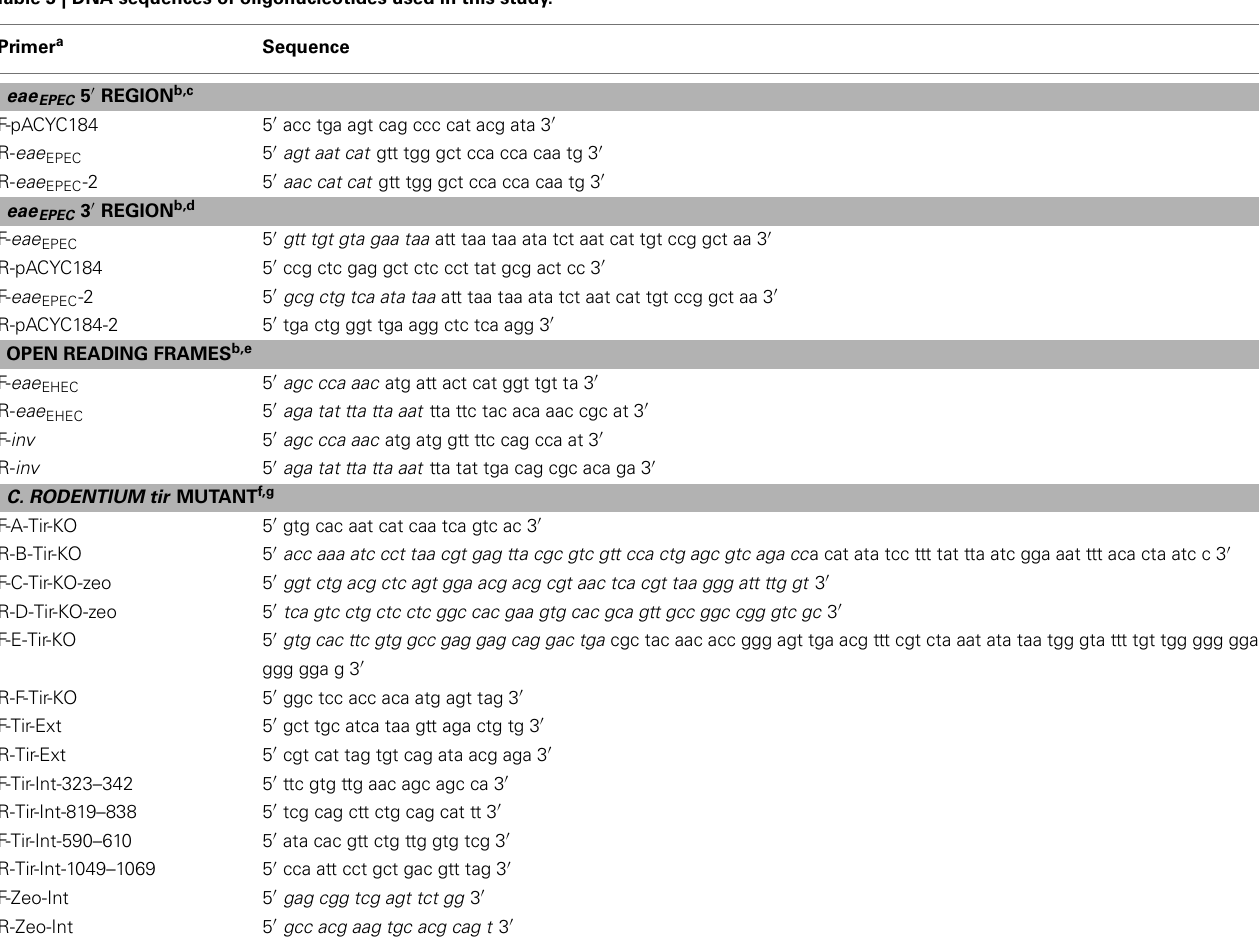
Table 3 | DNA sequences of oligonucleotides used in this